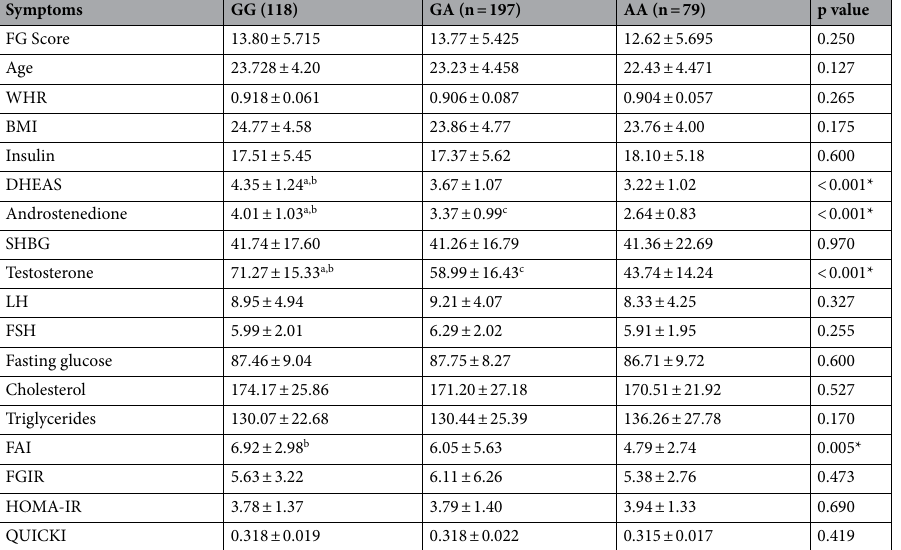
Table 4. Clinical characteristics, hormonal and biochemical profile of Log-additive genotype model in PCOS women. Data presented as mean ± SD. *p-value < 0.05 significant. p values calculated by one way Analysis of Variance (ANOVA) independent standard weighted-means analysis and intergroup association tested by Post hoc Tukey HSD test. PCOS polycystic ovary syndrome, BMI body mass index, FG Score Ferriman Gallwey Score, LH luteinizing hormone, FSH follicle stimulating hormone, SHBG sex hormone binding globin, DHEAS dihydroepiandrostenedione sulphate, HOMA IR homeostasis model assessment-estimated insulin resistance, QUICKI quantitative insulin sensitivity check index, FAI free androgen index, FGIR fasting glucose insulin ratio. a GG vs GA p < 0.05. b Represents GG vs AA p < 0.05. c Represents GA vs AA p < 0.05.